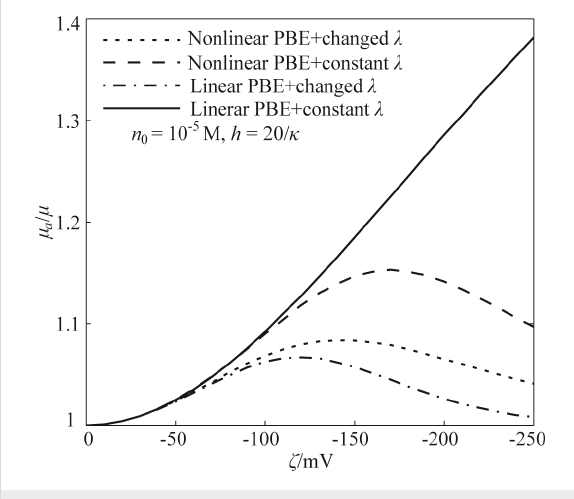
Figure 3: The effect of the zeta potential on the apparent viscosity of the lubricant based on different assumptions and theoretical models. The “Nonlinear PBE+changed λ ” case is the model established in the present